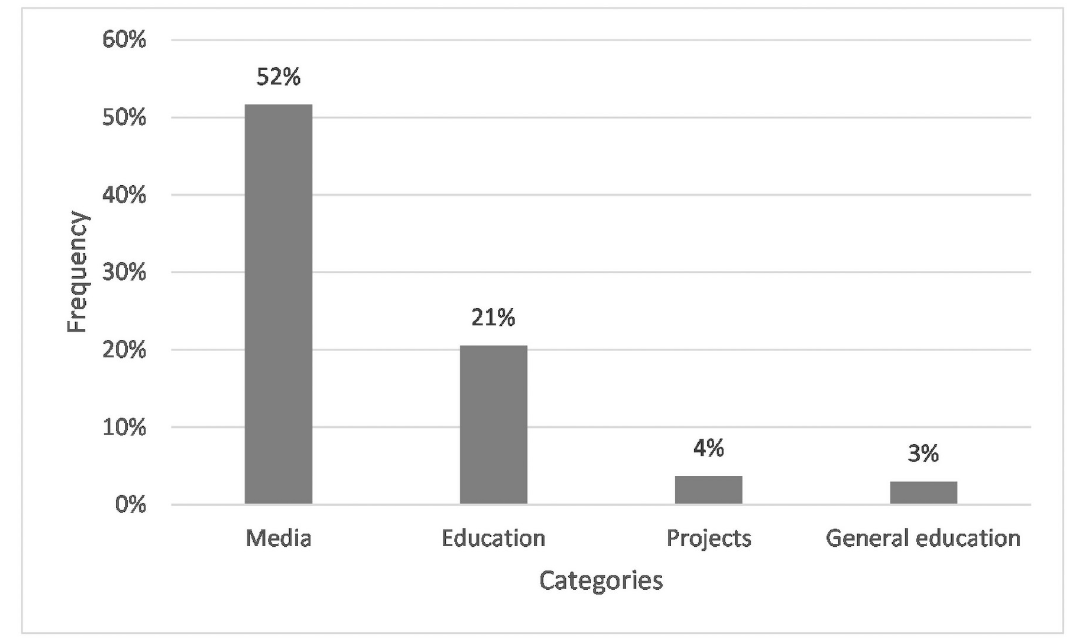
Fig 5. Frequencies of students whose answers assigned to the corresponding categories for Q2: “Where do you get your information about microplastics from?” N = 267. Open question with categories formed from students’ answers.